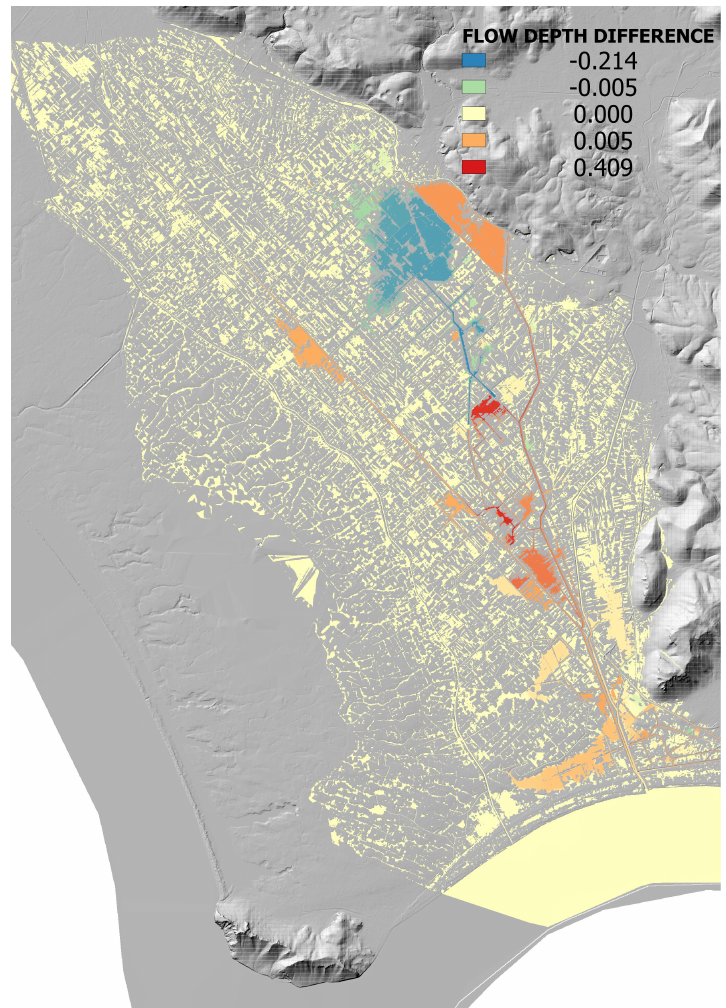
Figure 8. Maximum flow depth difference between configuration with 1.5 increase of pumping flow rate of each single pump (9 m 3 /s) at Mazzocchio pumping station and the current one (6 m 3